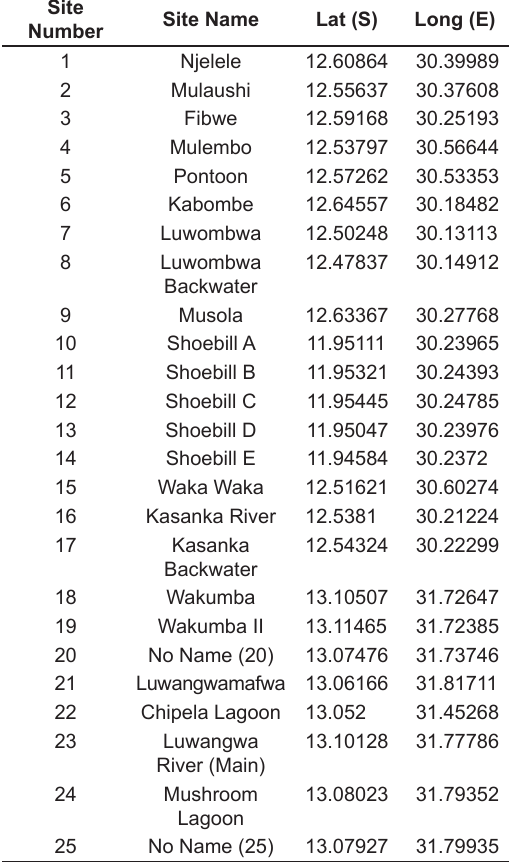
Table 1. Coordinates for sites sampled in Zambia.